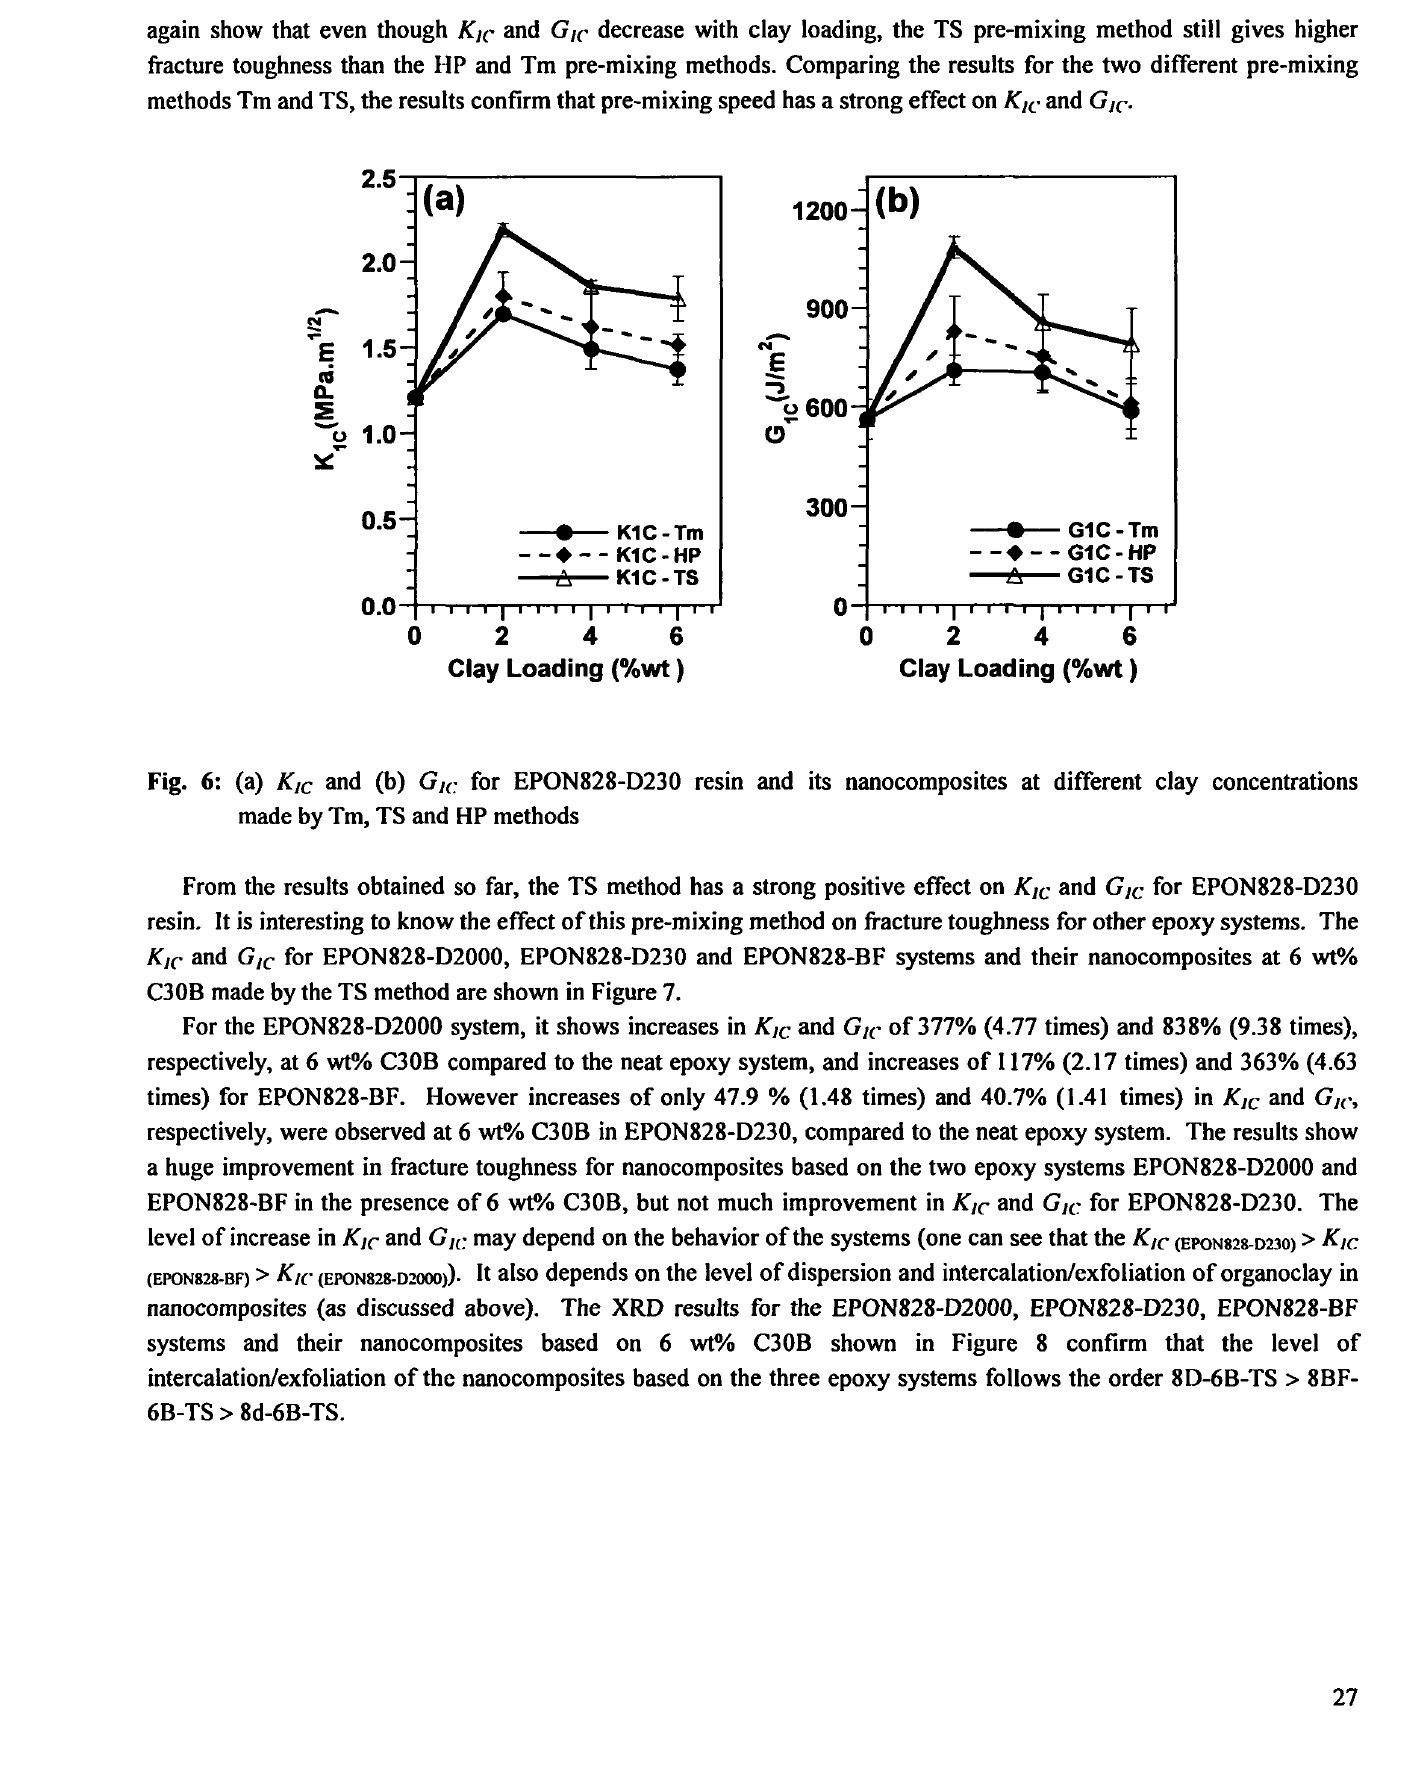
Fig. 6: (a) K and (b) G for EPON828-D230 resin and its nanocomposites at different clay concentrations ]C lc made by Tm, TS and HP